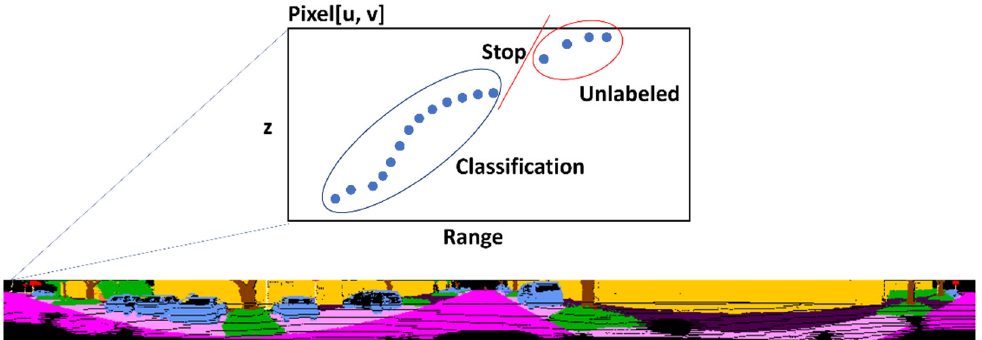
Figure 10. ABD Figure 10. ABD postprocessing.